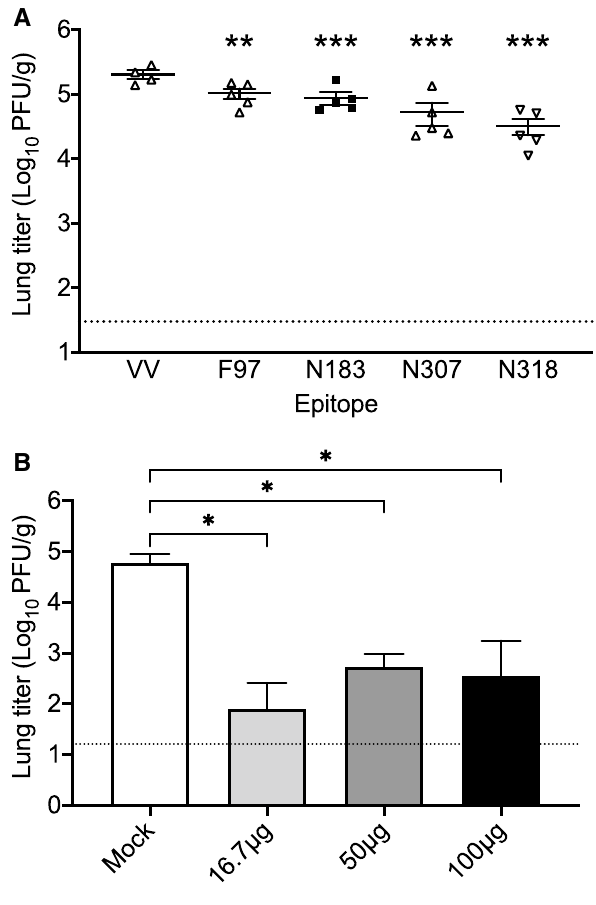
Figure 4. Epitope vaccination with HMPV peptide reduces lung virus titer in B7tg mice. ( A ) B7tg mice were vaccinated with LPS-matured bone marrow-derived DCs loaded with vaccinia virus (VV) or individual HMPV peptides, allowed to rest for 2 weeks, and then infected i.n. with 1 × 10 6 PFU HMPV. ( B ) B7tg mice were vaccinated with combined HMPV peptides plus LPS, allowed to rest for 4 weeks, and then infected i.n. with 1 × 10 6 PFU HMPV. In both experiments, lungs were collected on day 5 post-infection and HMPV titer determined using plaque assay. Error bars represent SEM. *P < 0.05, **P < 0.01, ***P < 0.001 compared to mock, one-way Anova with Dunnet’s correction for multiple comparisons. Dotted line indicates limit of